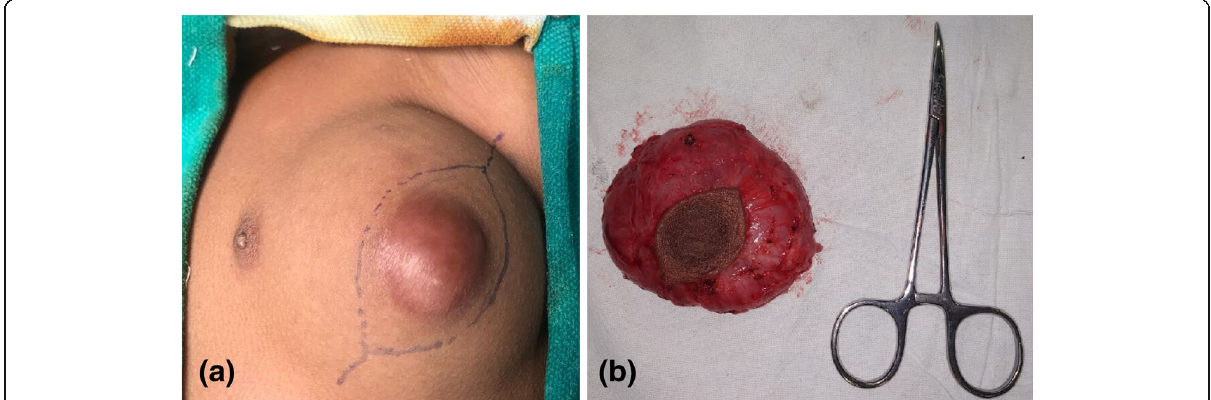
Fig. 2 a Incision for accessory breast excision. b Excised